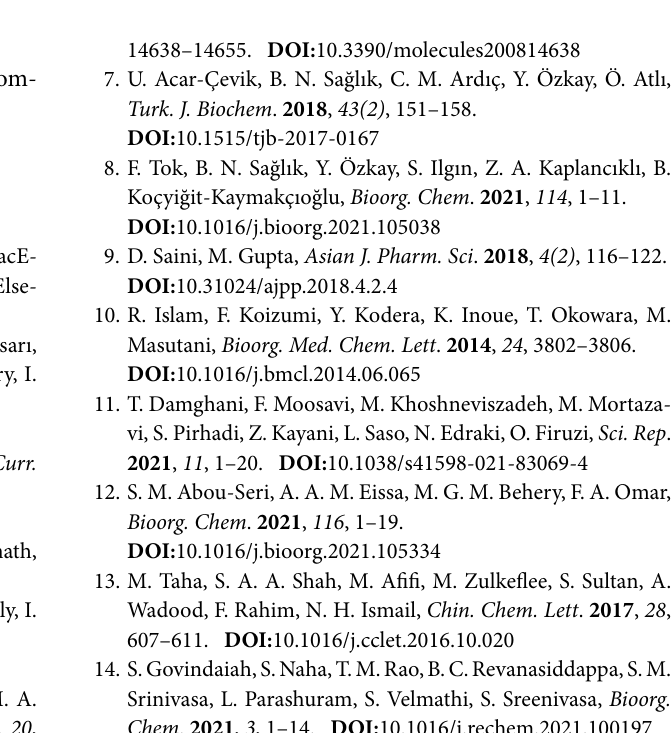
Figure 7 . The BOILED-Egg model of target compounds ( 3a - u